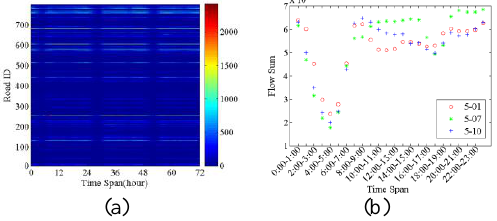
Figure 2. Traffic flow of roads in each period